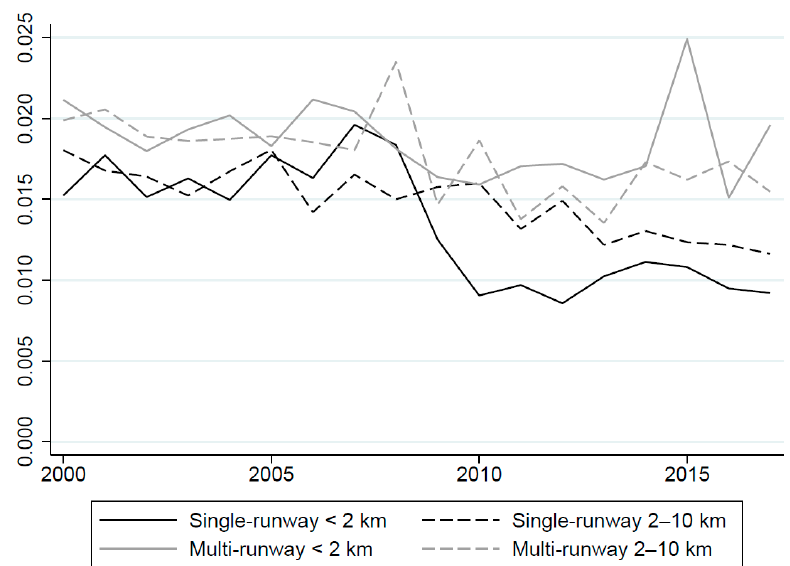
Figure 3. Cardiovascular mortality rate (age 65 and older) by airport type and distance from airport: CEM sample. Annual averages calculated using CEM weights assuming a 2 km treatment group.